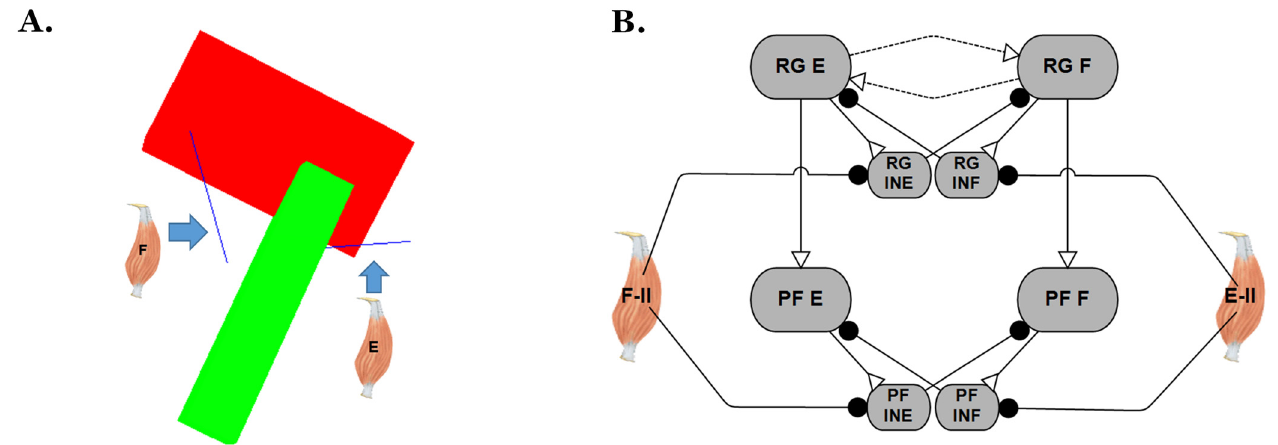
Figure 8. Schematics for the single joint biomechanical model. ( A ) Single joint (hip) physics model shown in the neutral position ( θ = 0). ( B ) Type II afferent feedback of the muscles was connected to CPG interneurons (CPG part of Figure 1B) on the opposite side through inhibitory connections.